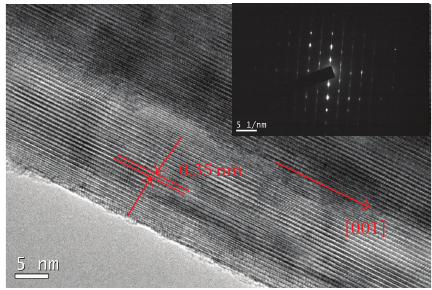
Figure 3: HRTEM and SAED (inset) of NS-TiO 2 NWs calcined at 600 ∘